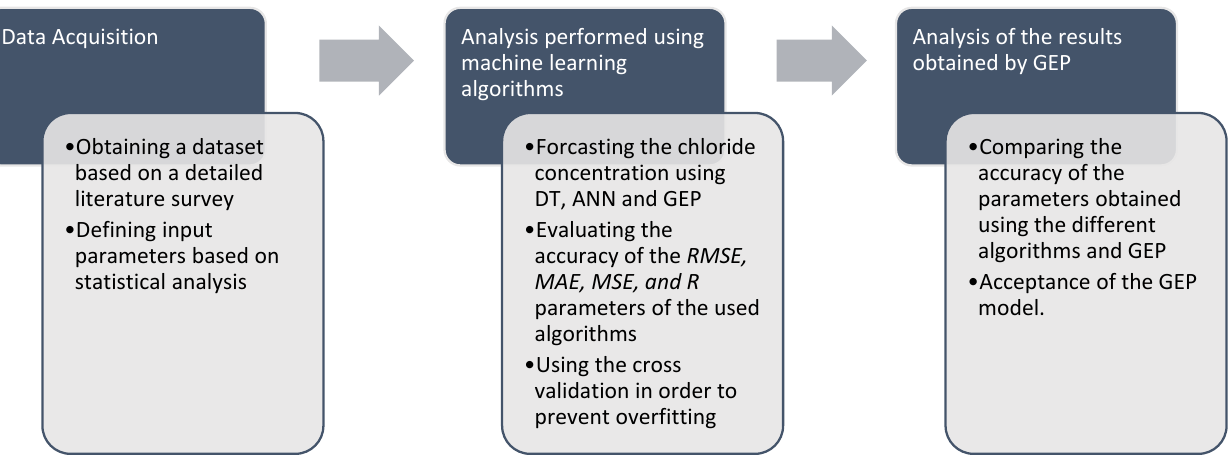
Figure 4. Flowchart of the research approach.